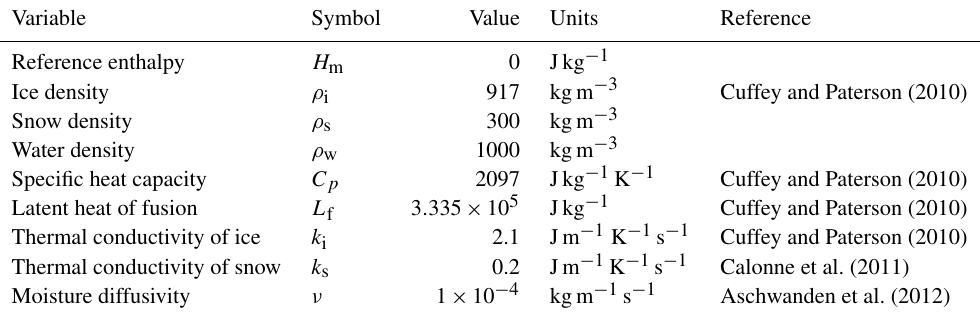
Table 2. Constants.